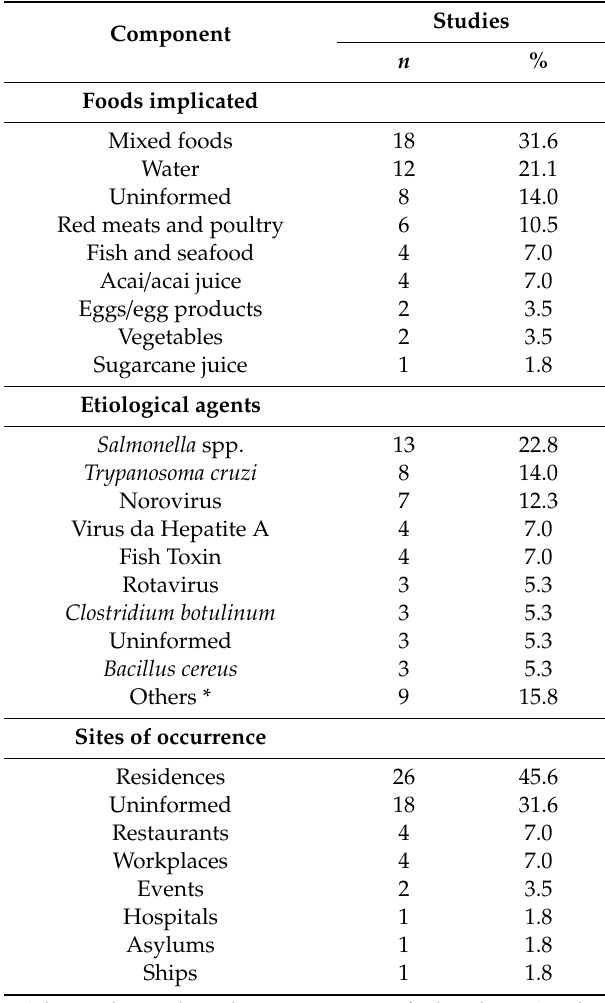
Table 3. Data from the scientific literature on foods implicated, etiological agents, and sites of foodborne disease outbreaks described in Brazil between 2000 and